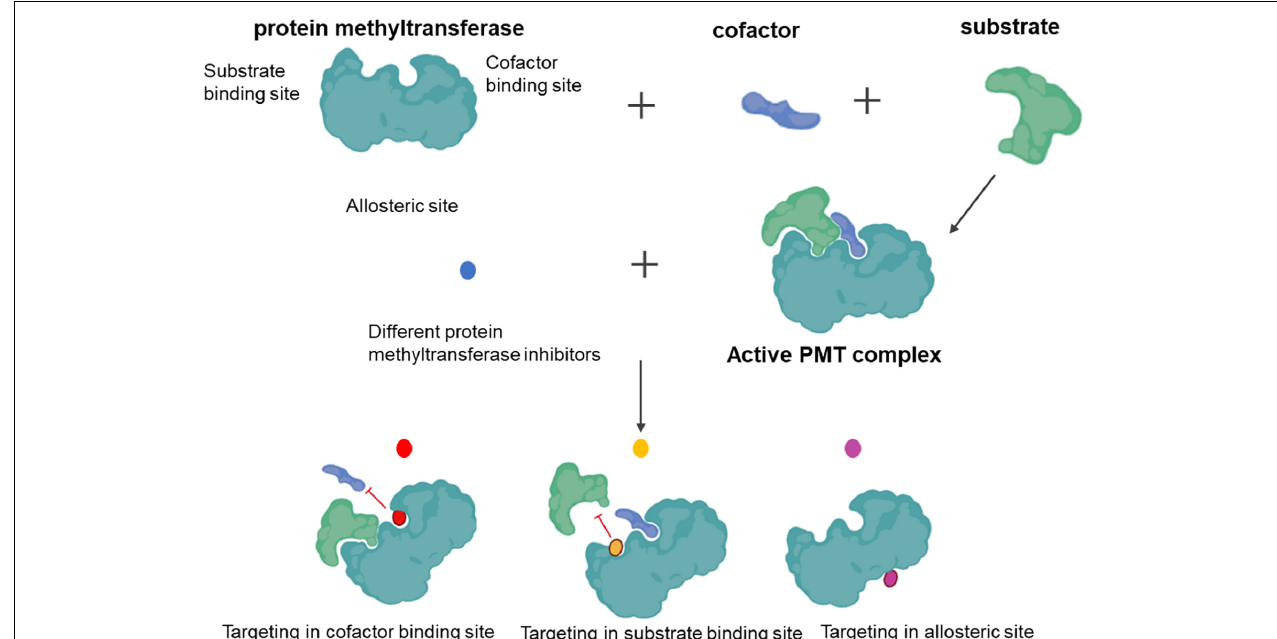
FIGURE 3 | Functional mechanism of protein methyltransferase